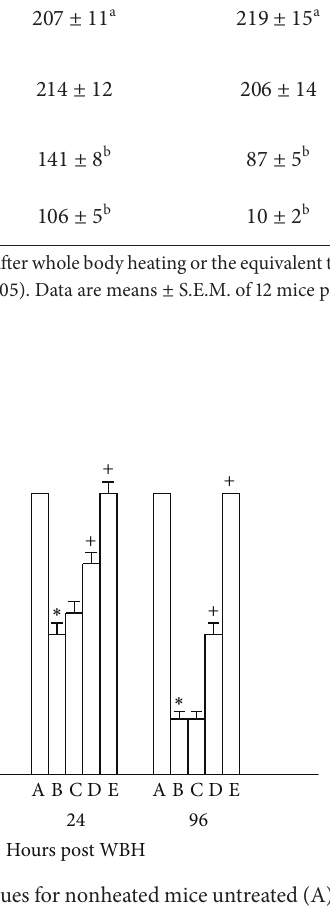
Figure 1: Percent survival values for nonheated mice untreated (A), heated mice treated with vehicle solution (B), heated mice treated with melatonin (0.2 mg/kg) (C), heated mice treated with melatonin (1mg/kg)(D),andheatedmicetreatedwithmelatonin(5 mg/kg)(E) 4–96 hours after whole body heating (WBH). Data are expressed as means ± S.E.M. for 12 mice per group. ∗ 𝑃 < 0.05 compared with nonheated mice untreated mice; + 𝑃 < 0.05 compared with heated mice treated with vehicle